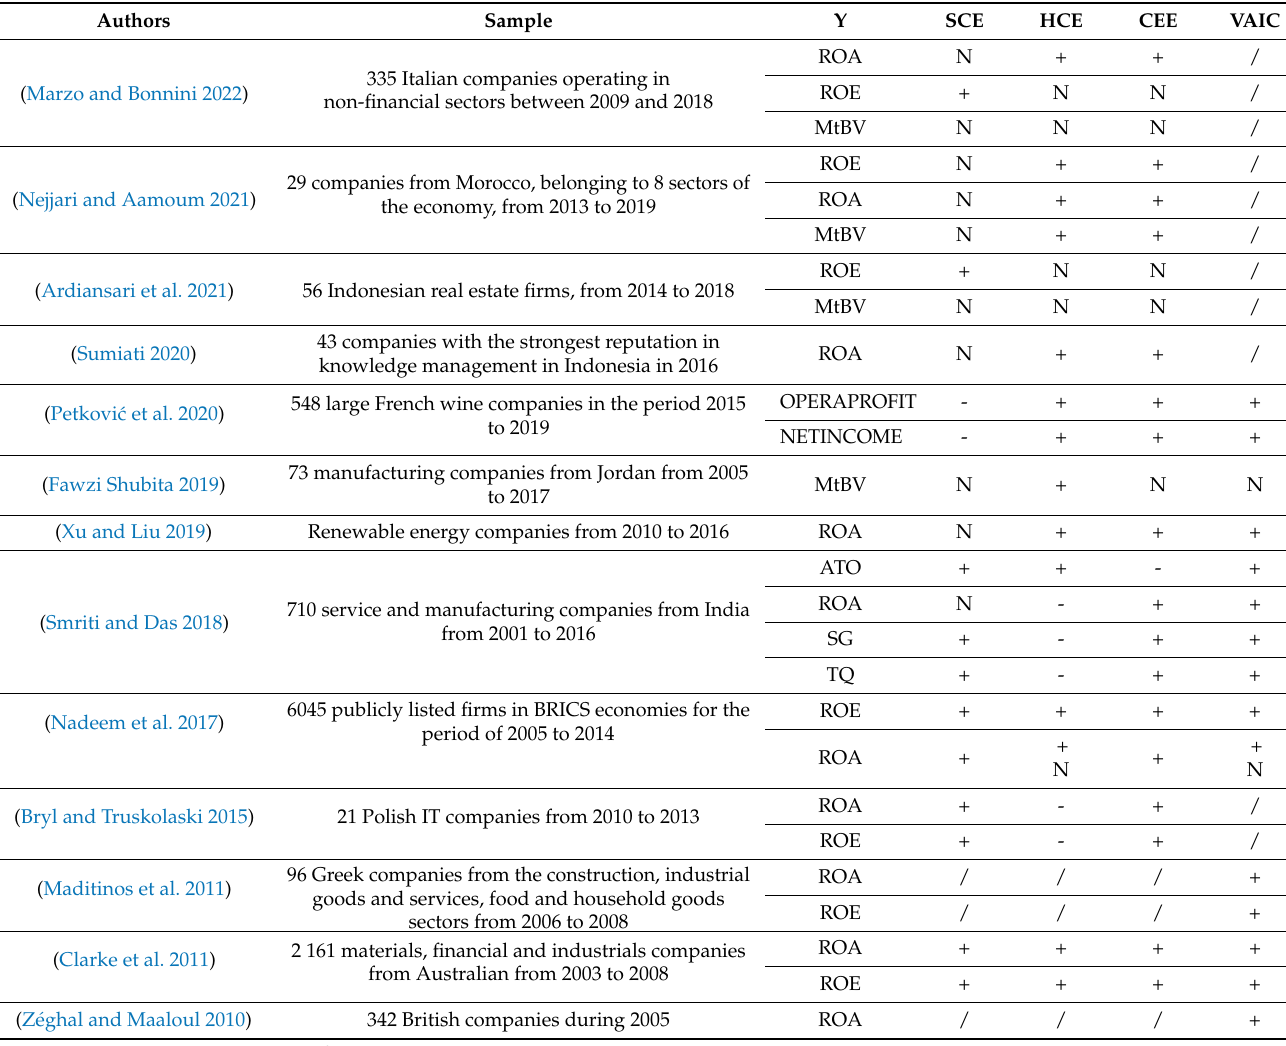
Table A1. Comparative analysis of the results of studies on the impact of intellectual capital on company performance. VAIC